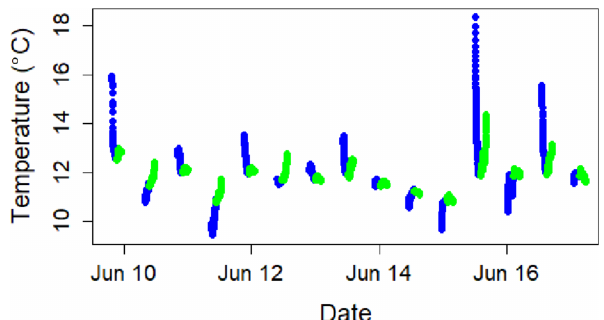
Figure A3. Time series example of temperature data at the Bay of Fundy Mini Buoy L2. Measured temperature during inundation by the Hobo data logger fixed to the top of the Mini Buoy L2. Colours indicate first and second half of inundation.